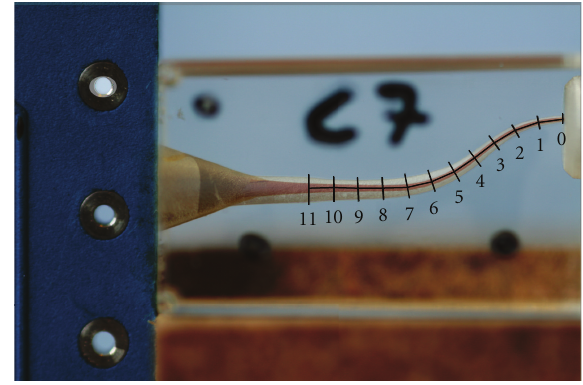
the instrumented canal ( X sup ), (2) the distance between the inferior limit of the initial canal and the inferior limit of the instrumented canal ( X inf ), and (3) the width of the shaped canal ( Y ).